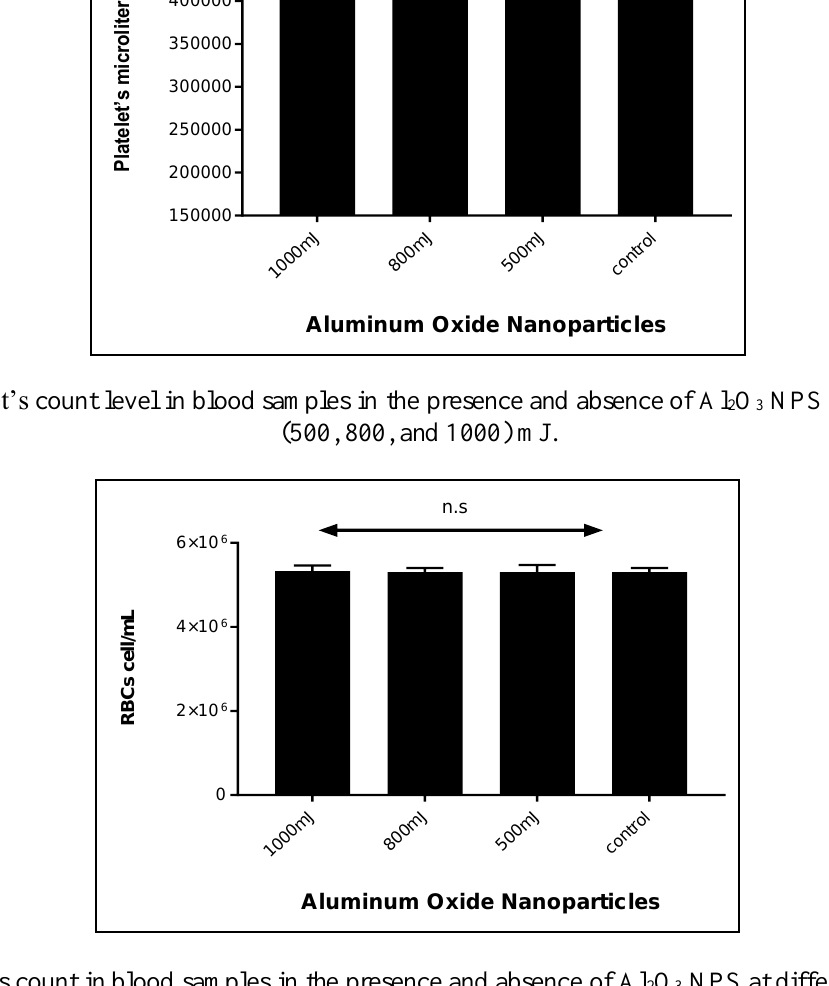
Figure 8: RBCs count in blood samples in the presence and absence of Al 2 O 3 NPS at different energy (500, 800, and 1000)